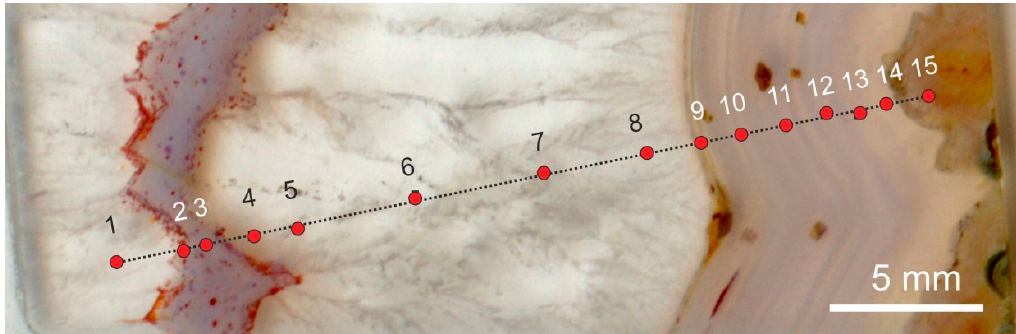
Figure 17. Micrograph of an agate from St. Egidien, Saxony (Germany) with a profile showing the analytical spots (spot numbers relate to analytical data in Table 2) of trace element analysis by LA ‐ ICP ‐ MS.